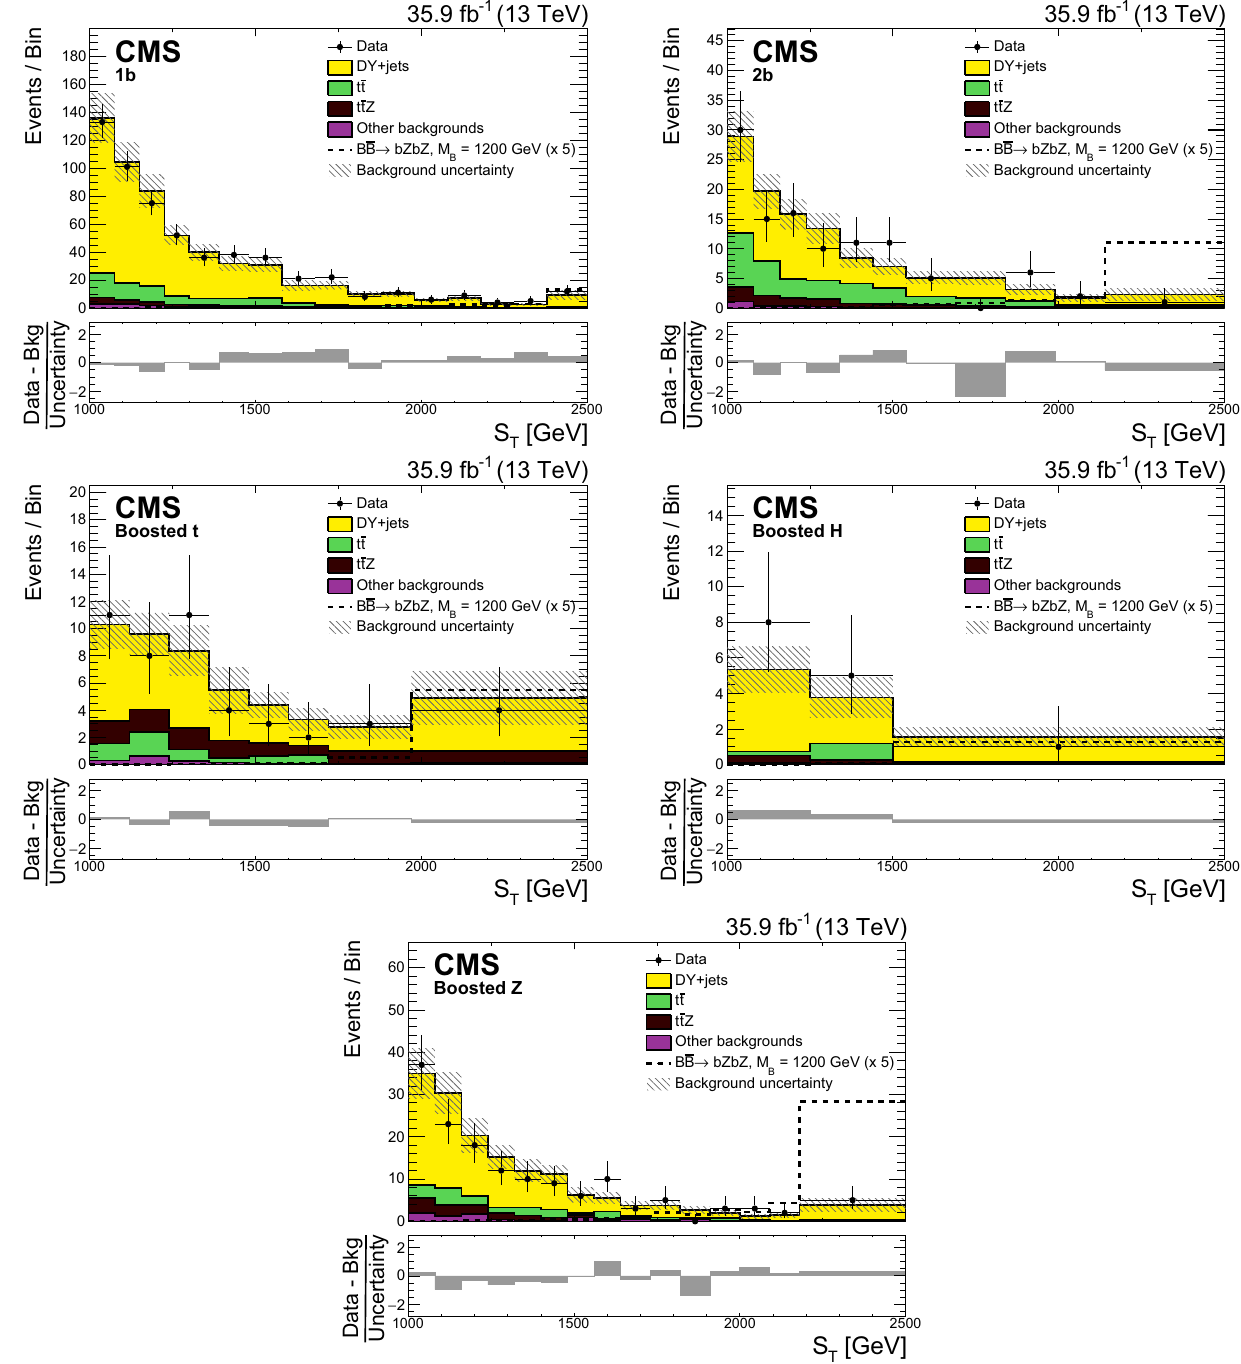
Fig. 6 The S T distributions for the 1b, 2b, boosted t, boosted H and boosted Z (left to right, upper to lower) event categories for the data (points with vertical and horizontal bars), and the expected background (shaded histograms). The vertical bars give the statistical uncertainty in the data, and the horizontal bars show the bin widths. The expected sig- nal for BB → bZbZ with m B = 1200GeV multiplied by a factor of 5